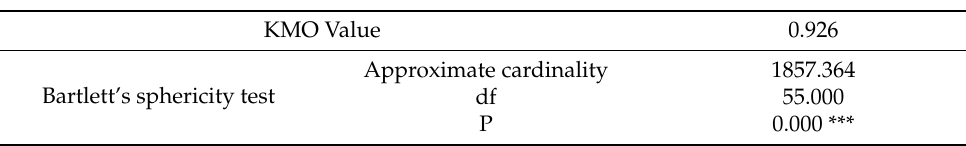
Table 5. KMO and Bartlett test